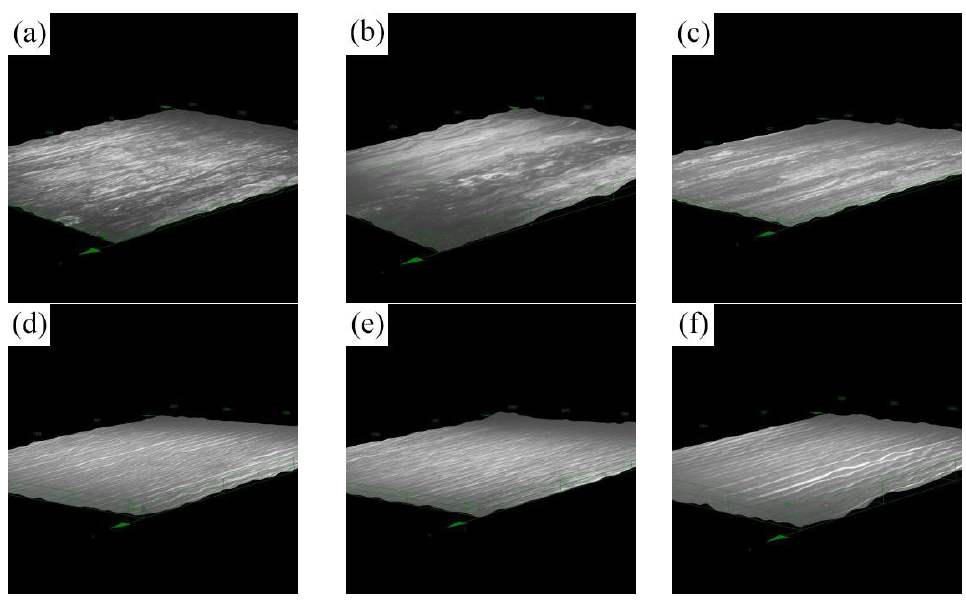
Figure 8. Three-dimensional surface morphology of tin bronze ( a – c ) and tin bronze-based ISSLB materials ( d – f ) (69 times), ( a , d ) 100 N, ( b , e ) 300 N, ( c , f ) 500 N.